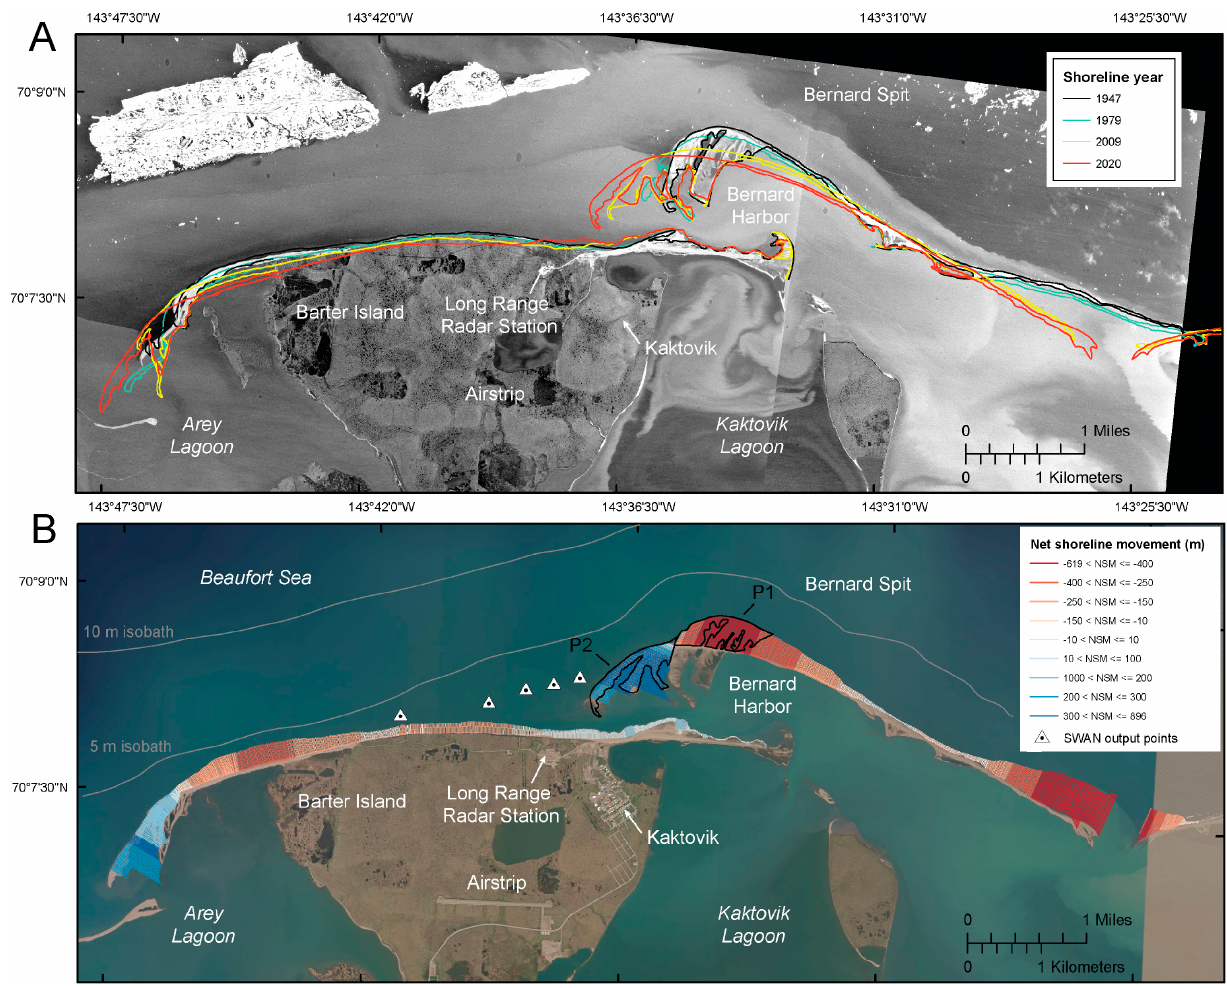
Figure 3. ( A ) Color-coded shoreline positions for 4 selected historical time periods, overlain on 1955 imagery. Note the formation of the inlet on the eastern Bernard Spit and the southerly retreat and westward extension of both Bernard Spit and western Barter Island between 1947 (black line) and 2020 (red line). Imagery base from USGS Earth Explorer. ( B ) Net shoreline movement of Barter Island and Bernard Spit between 1947 and 2020 overlain on 2020 imagery. The lengths of the colored lines show the total distance the shoreline moved over the study period. Red lines indicate retreat and blue lines progradation. The area eroded on western Bernard Spit (P1) is nearly equal to the area deposited in P2. Isobaths represent circa 2011 bathymetry [4]. Imagery base is Alaska High Resolution Imagery (https://gis.data.alaska.gov/pages/Imagery% 20Program accessed on 1 October